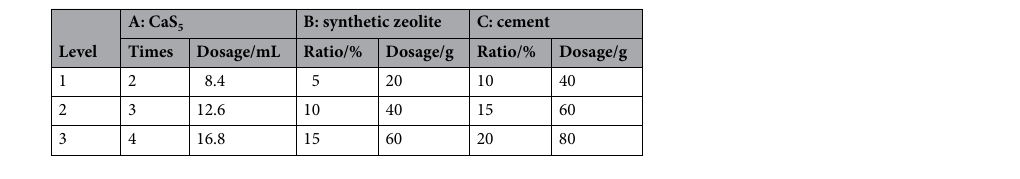
Table 6. Factor level table of orthogonal